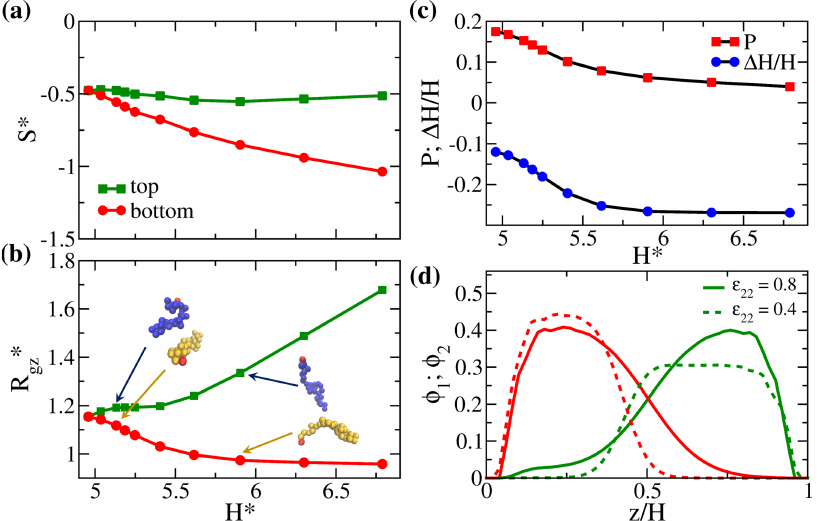
Figure 3. ( a ) Scaled entropy per bead (S*), ( b ) scaled average z -component radius of gyration ( R ∗ gz ), and ( c ) degree of the interpenetration of polymers from two walls determined from different measures ( P and ∆ H / H ; see text) plotted against the scaled gap thickness ( H ∗ = H / R 0 g ) for systems AA, AB, AC, AD, AE, AF, AG, AH, AI, and AJ (symbols from left to right). ( d ) Local volume fraction distributions of the system AC ( ε 22 = 0.8) and the system AH ( ε 22 = 0.4). The green lines are the profiles for the top brush and the red curves correspond to the profiles for the bottom brush. For clarity, the corresponding representative snapshots of a pair of grafted chains are shown in ( b